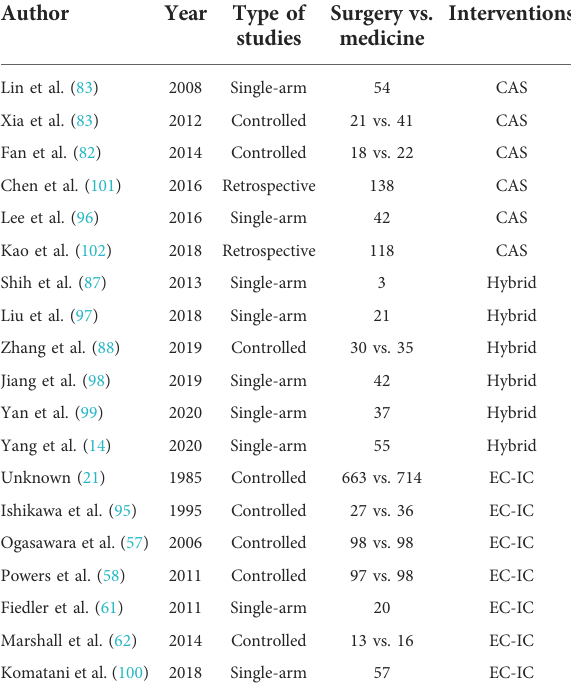
TABLE 1 Basic characteristics of included studies.